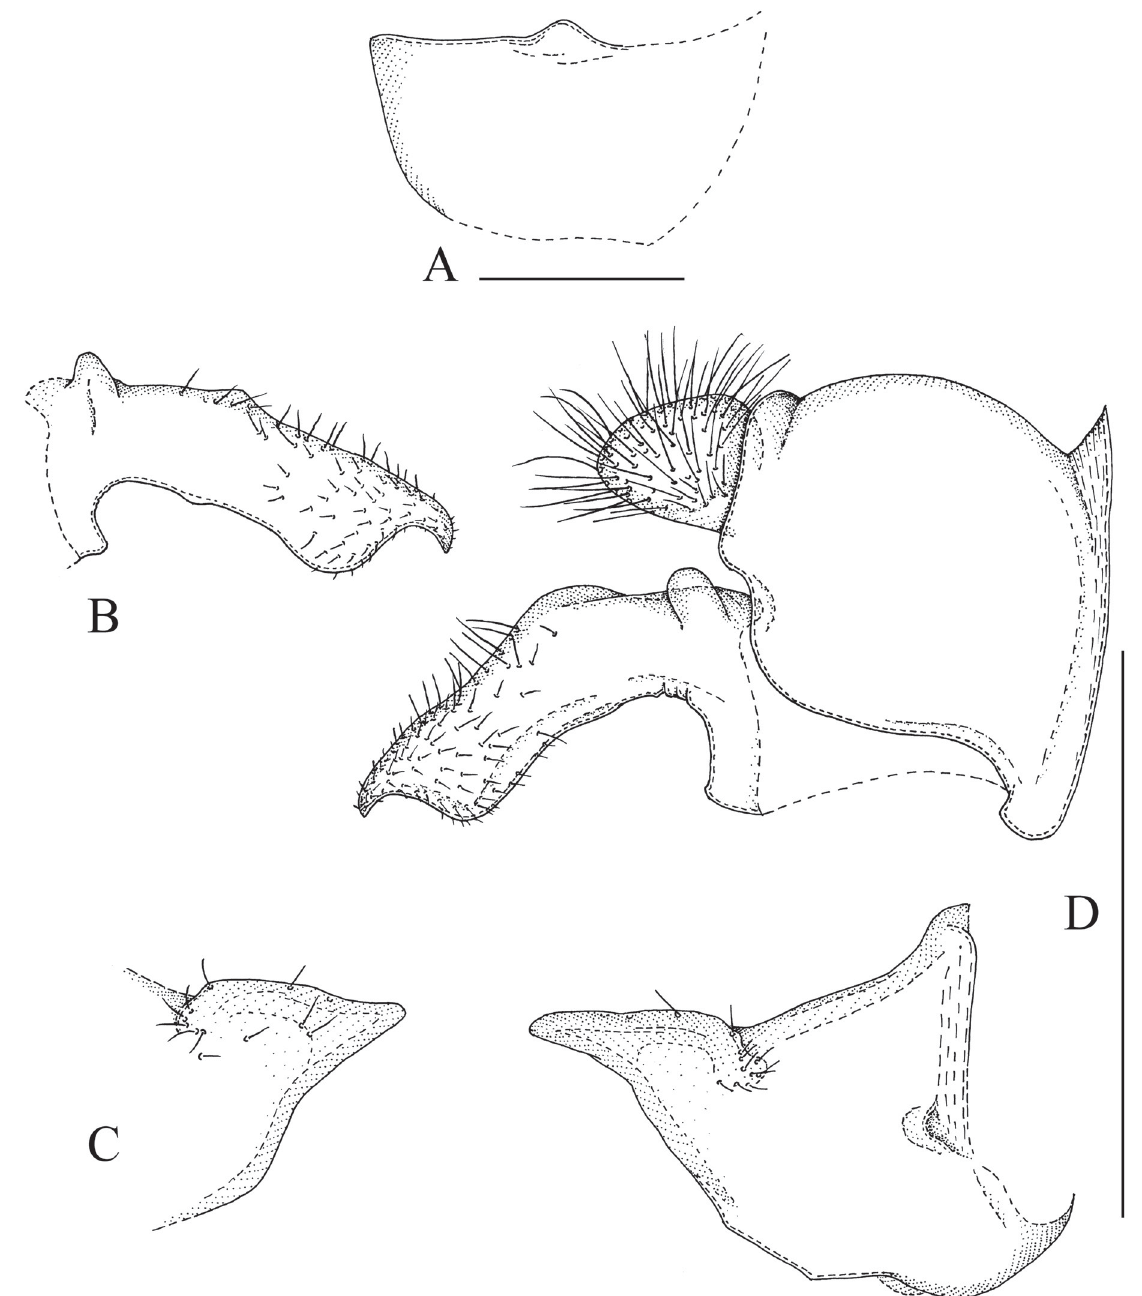
Fig. 36. Sphegina (Asiosphegina) ghatsi sp. nov., holotype, ♂ . A . Sternum IV, ventral view. B . Left surstylus, lateral view. C . Le ft superior lobe, lateral view. D . Genitalia, right side, lateral view. Scale bars = 0.5